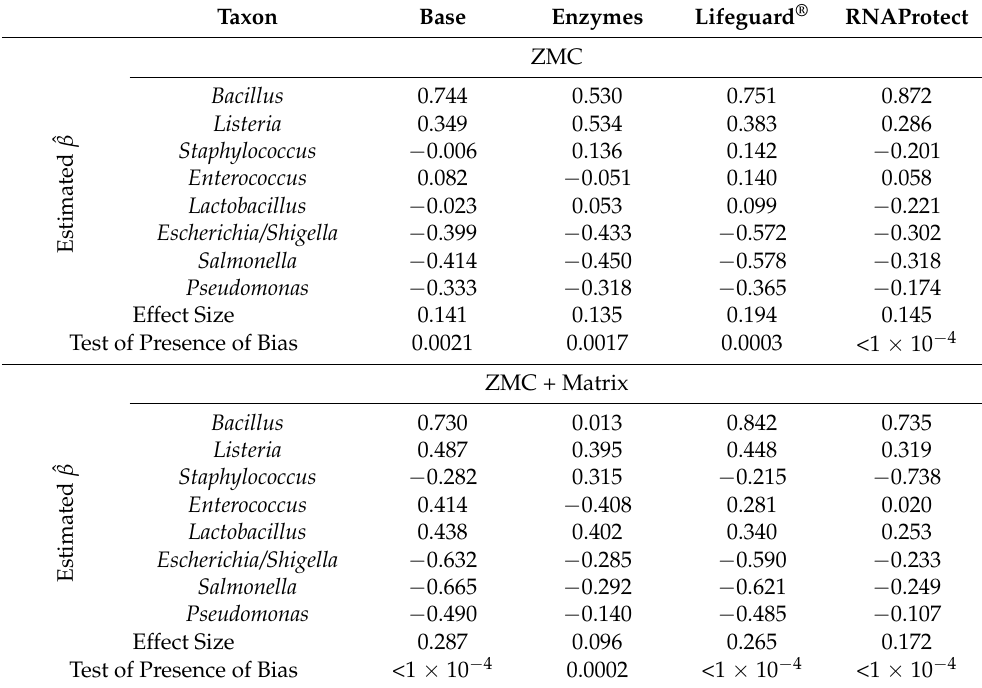
Table 1. Tests and estimates of log-Bias Factors (cid:101) β j , k for taxa in the ZMC and ZMC + Matrix samples.